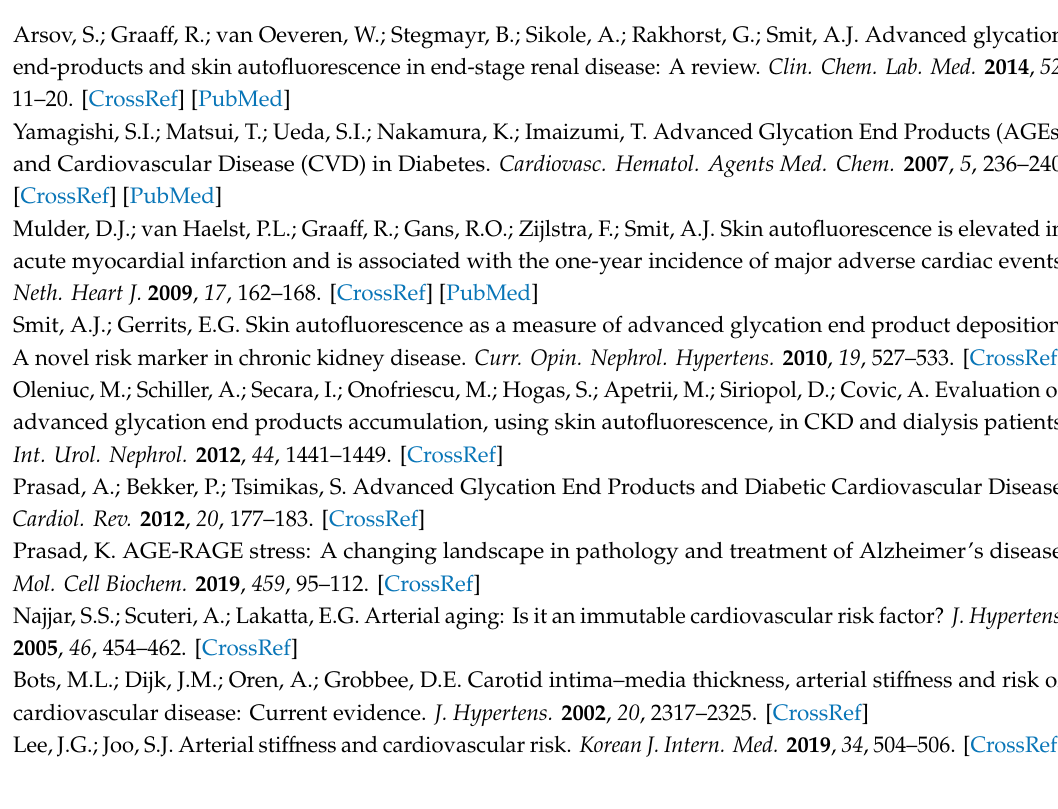
Table S3. Quality assessment with the tool for observational cohort and cross-sectional studies of the National Heart, Lung, and Blood Institute (outcome: PWv); Table S4. Quality assessment with the tool for observational cohort and cross-sectional studies of the National Heart, Lung, and Blood Institute (outcome: C-IMT); Table S5. Random e ff ects meta-regression analysis to determine if variables included in studies are significant moderators of relationship between PWv or C-IMT and SAF; Figure S1. Forest plot including the correlation between pulse wave velocity or carotid intima media thickness and skin autofluorescence in studies that included a control group; PRISMA 2009